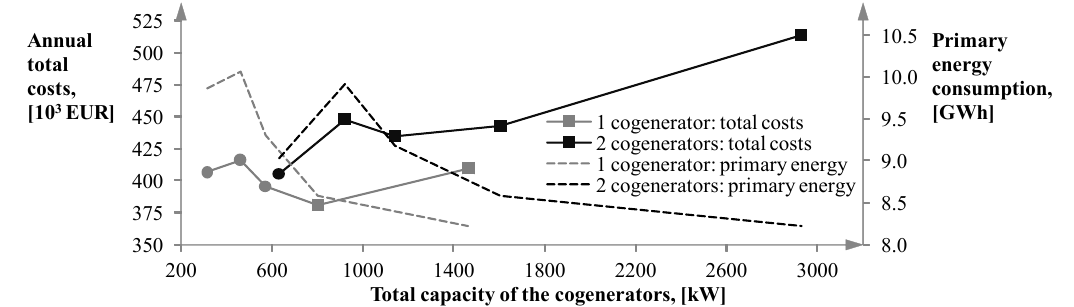
Figure 4. Annual total costs and primary energy consumption for different models and numbers of cogeneration